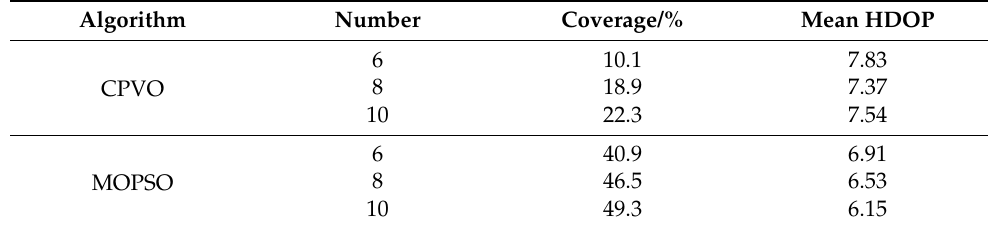
Table 2. Comparison of MOPSO and